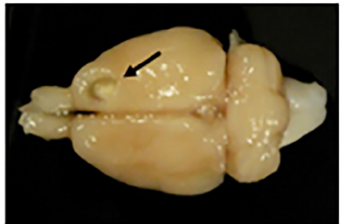
Figure 13. Motor frontal cortex ablation. Photograph of a rat brain with a motor cortex ablation (shown with a black arrow). At the bottom of the lesion is a slightly paler shade that corresponds to the corpus callosum (or white matter).